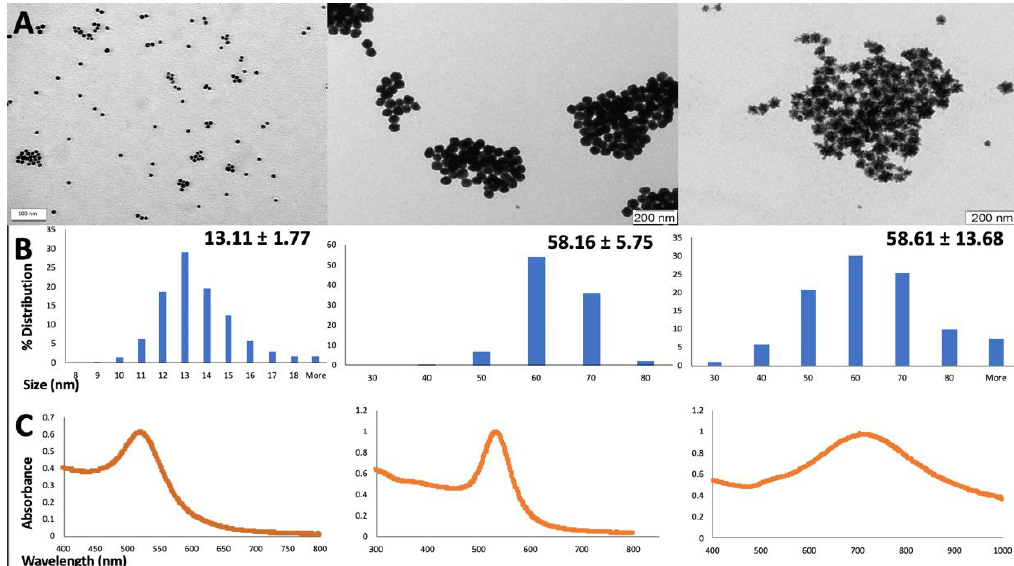
Figure 1. Physical-chemical characterization of the 13 and 60 nm gold nanospheres and 60 nm gold nanostars. Data obtained from ( A ) TEM analysis, ( B ) size distribution by frequency obtained from TEM images and ( C ) their corresponding UV-Vis spectra. TEM images were analyzed using ImageJ software through measurement of a minimum of 100 nanoparticles. For the UV-Vis spectra, the samples were diluted 1 to 5 in 2.2 mM citrate solution for citrate-capped AuNPs and 10 mM phosphate buffer pH 7.2 for MUA capped-AuNPs.